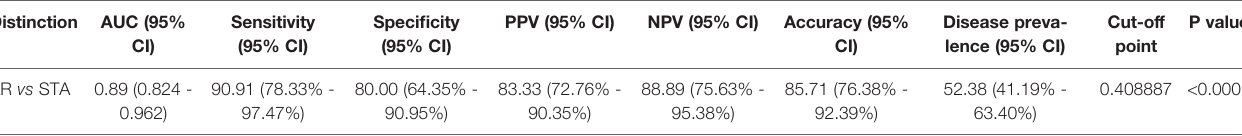
PPV, positive predictive value; NPV, negative predictive